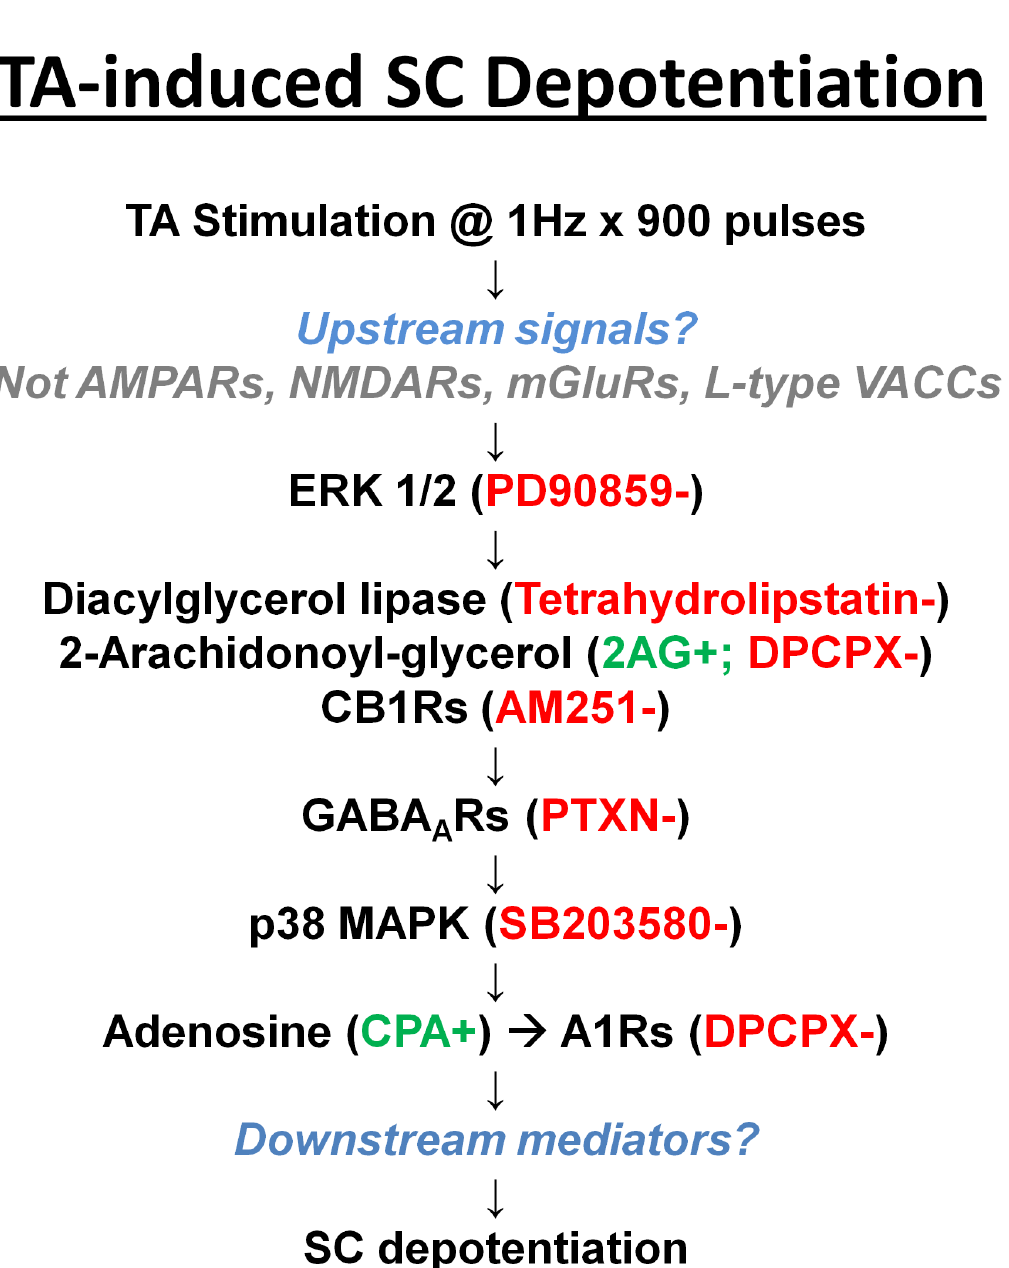
Fig 9. Mechanisms contributing to TA-induced depotentiation. The figure presents a scheme for signaling involved in TA-induced SC LTP-D based on the effects of selective agonists and antagonists. Based on results to date, activation of ERK 1/2 appears to occur early in the cascade, while A1R activation is a late